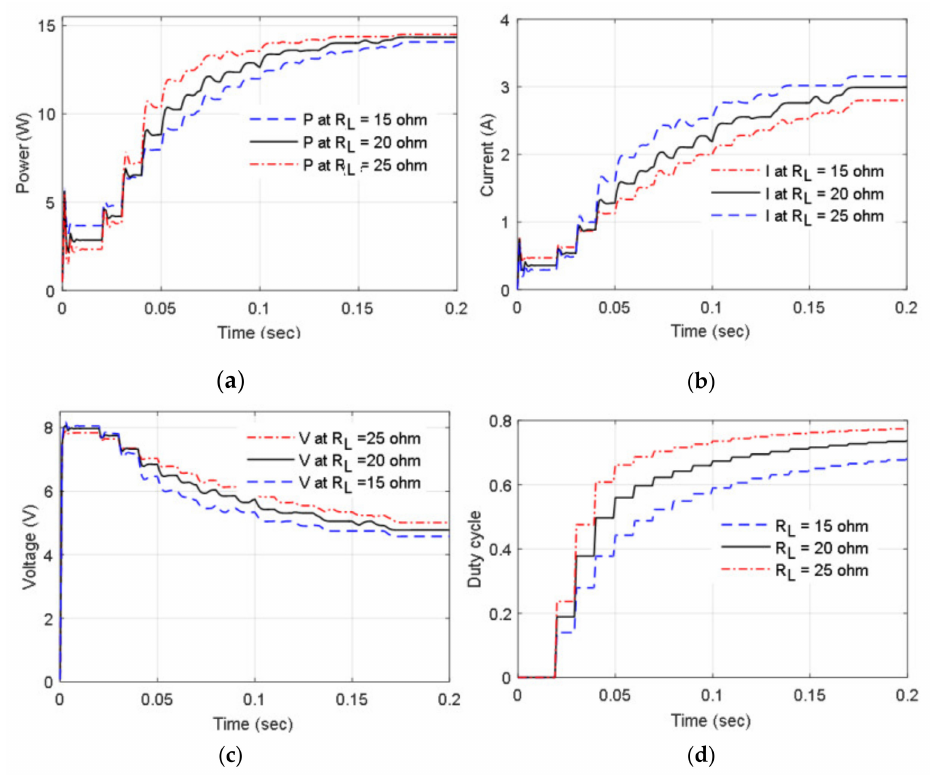
Figure 14. TEG performance using the INR-based MPPT for the di ff erent load: ( a ) power output; ( b ) current flow; ( c ) voltage output; ( d ) duty